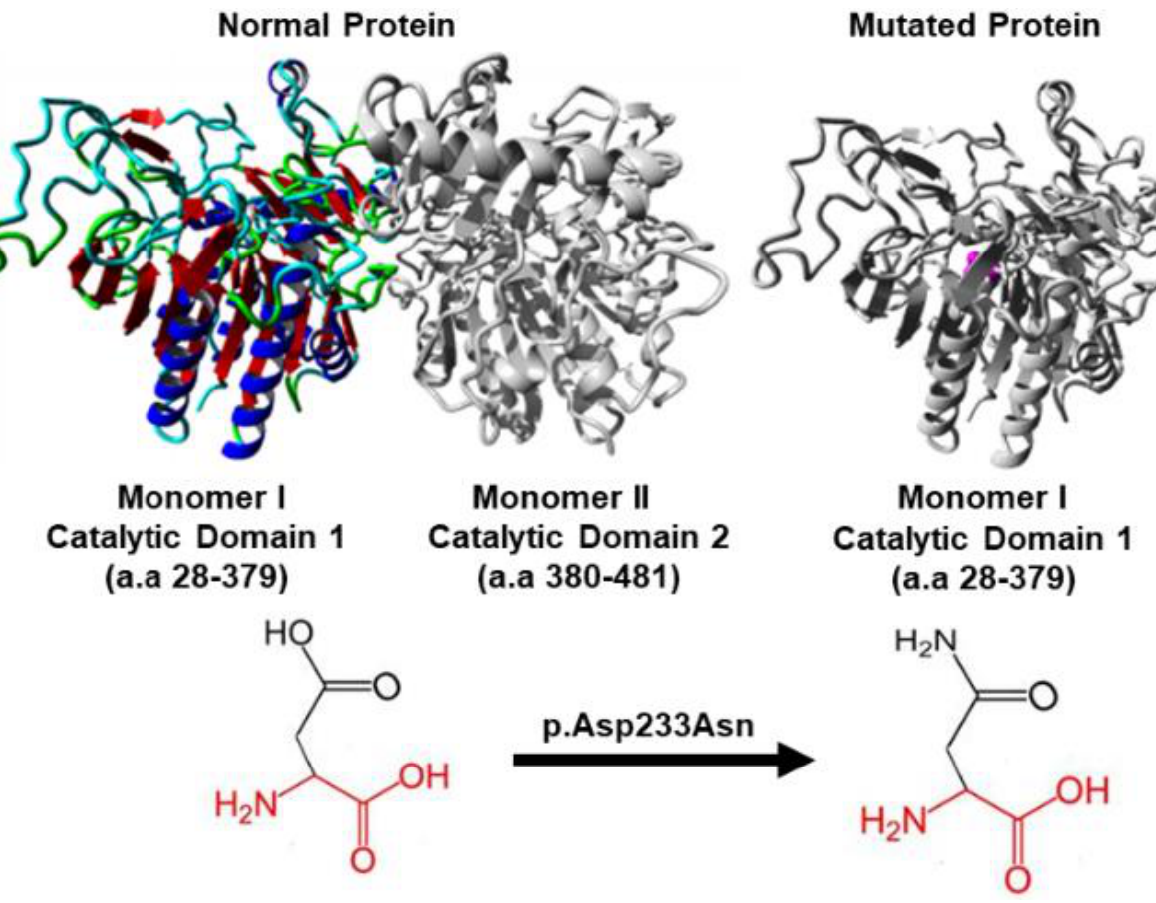
Figure 5. The p.Asp233Asn mutation analysis of GALNS using HOPE. The normal protein structure is represented as homodimer, with each monomers having catalytic domain. Domain 1 from amino acid (a.a) residues 28 to 379, and an antiparallel β -strands in domain 2 from a.a residues 380 to 481. The ancestral protein (left side) has aspartic acid (Asp) at position 233 and is negatively charged residing in domain 1, colored by element; α - helix = blue, β -strand = red, turn = green, 3/10 helix = yellow and random coil = cyan, while Domain 2 is colored grey. The monomer I with mutated residue (right side), shown in grey, has the side chain of asparagine (Asn) at position 233 (colored magenta) having neutral charge, is represented as small balls located at the catalytic domain 1 of the protein causing functional disturbance.